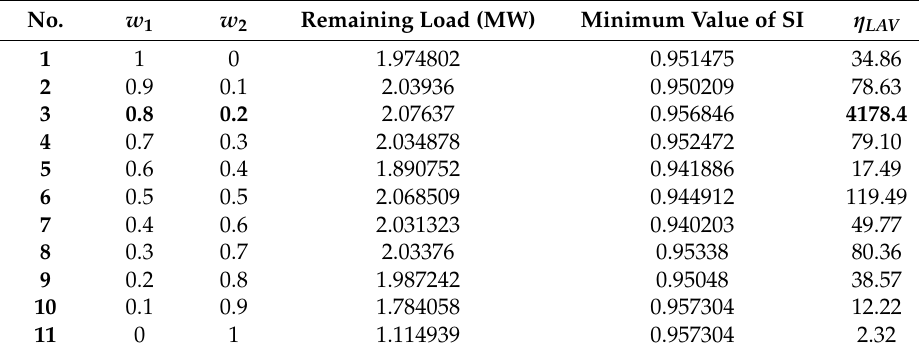
Table 4. Weightage set and corresponding performance index based on Least Average Value (LAV) by applying proposed load shedding with consideration priority limit at time